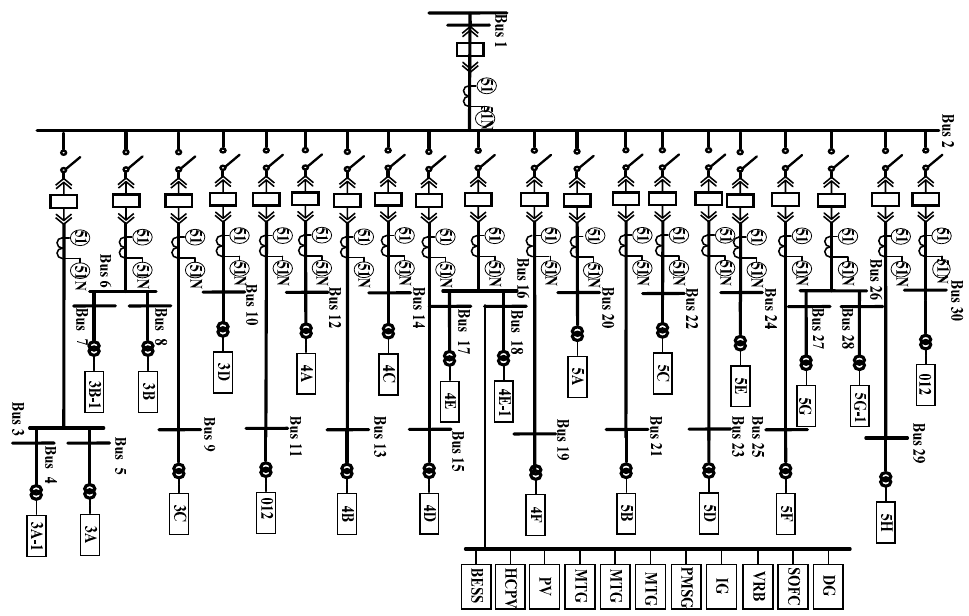
Figure 12. Single line diagram of 11.4 kV substation of the Institute of Nuclear Energy Research (INER) 30 ‐ Bus system.